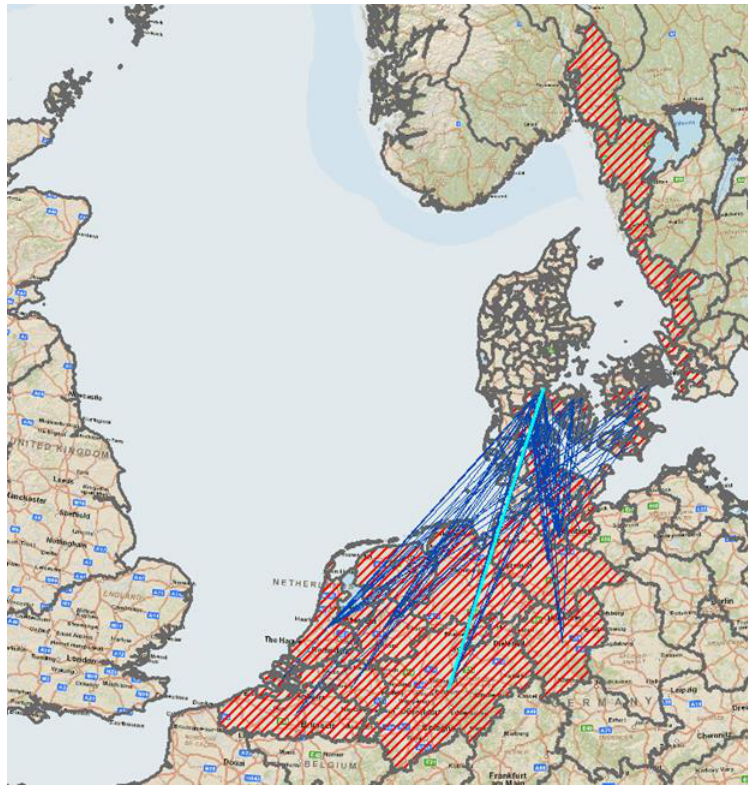
Figure 6. One-leg ’land border’ road chains for Commodity group 22